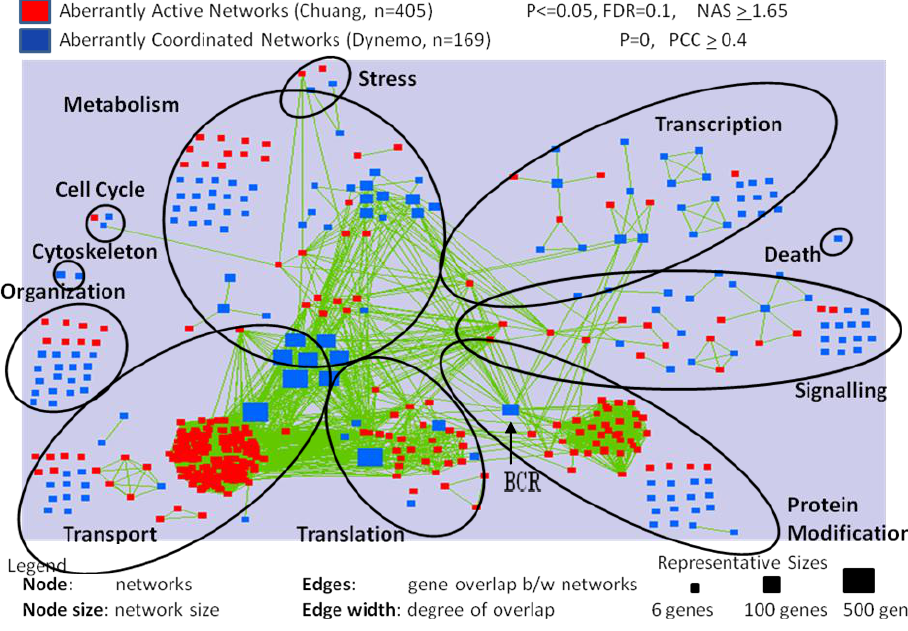
Figure 2. Nodes represent differentially activated (red squares) and organized (blue squares) networks in metastatic OS samples. Green edges represent genetic overlap between networks. Genes in significant networks were annotated with simplified Gene Ontology Slim Generic terms (Table 6), and networks were grouped into processes by the most commonly occurring term in each network. Networks meeting the cut-off conditions detailed at the top of the figure were visualized with the Enrichment Map plugin for Cytoscape. The size of each node reflects the number of genes included in the network.